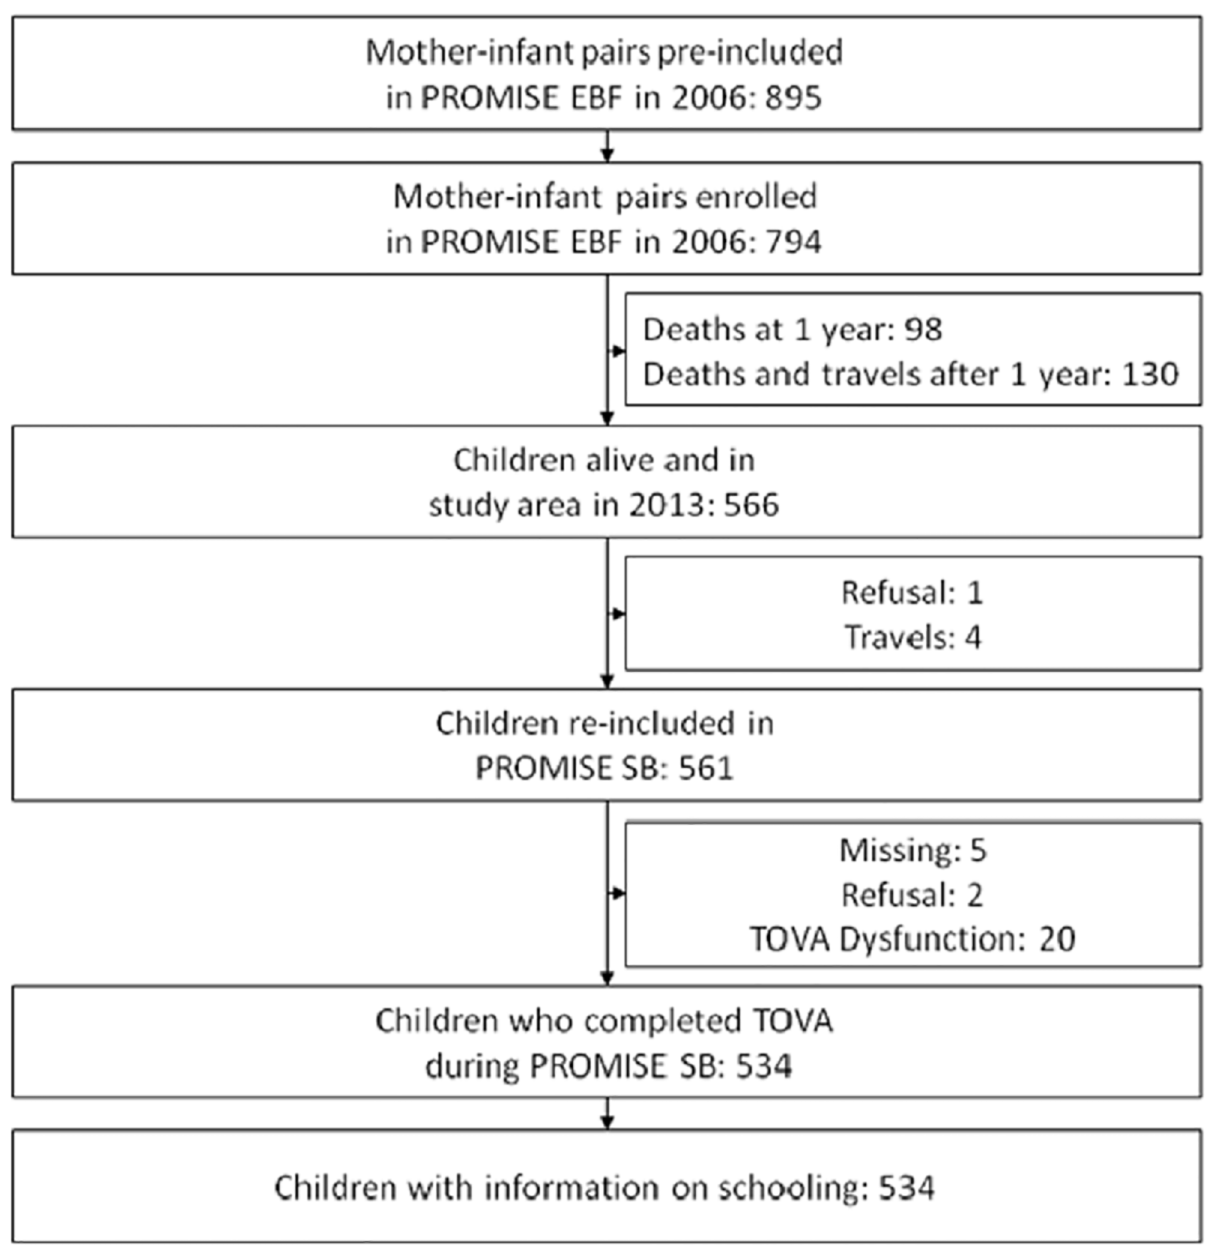
Fig 2. Study profile of children who completed the TOVA and having information on schooling at the PROMISE Saving Brains study in rural Burkina Faso.